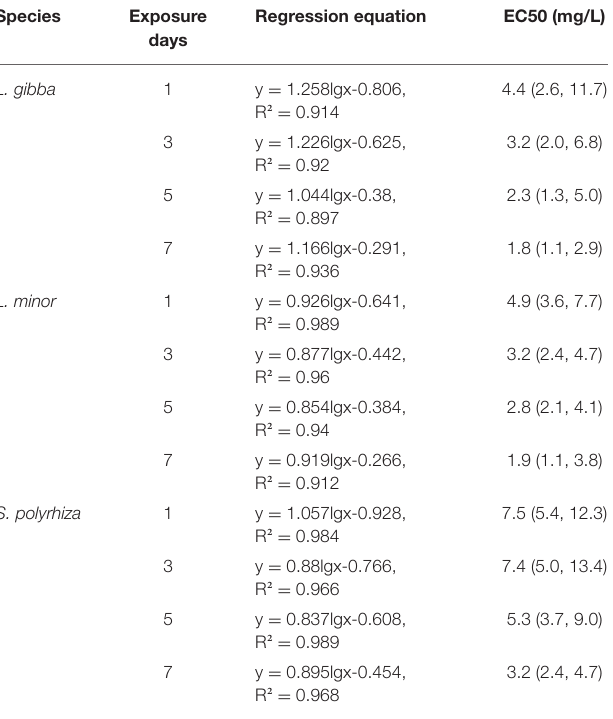
TABLE 1 | Toxicity assessment of dose-response regression equations for L. gibba , L. minor and S. polyrhiza under different Hg treatments. Species Exposure Regression equation EC50 (mg/L) days